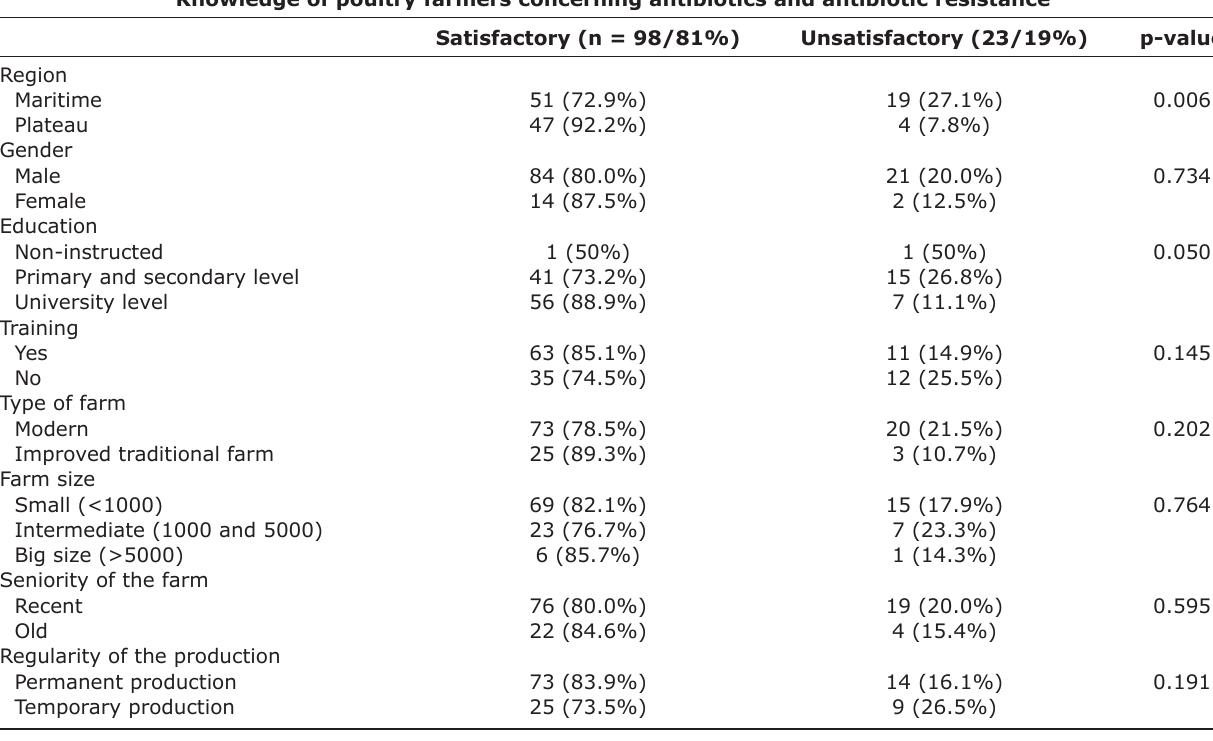
Table-4: Knowledge of poultry and pig farmers concerning antibiotics and antibiotic resistance. Knowledge of poultry farmers concerning antibiotics and antibiotic